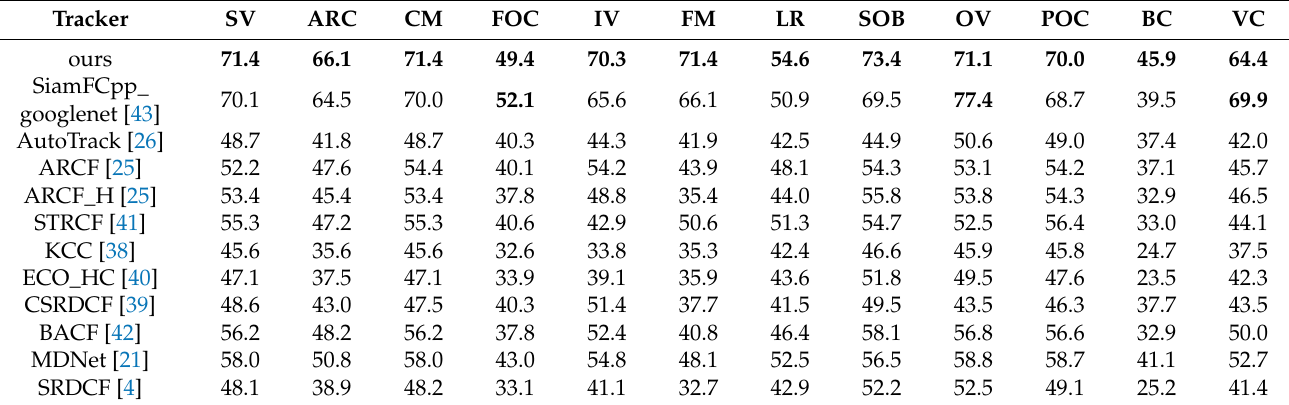
Table 6. Precision comparison results of the state-of-the-art trackers on the UAV20L dataset.